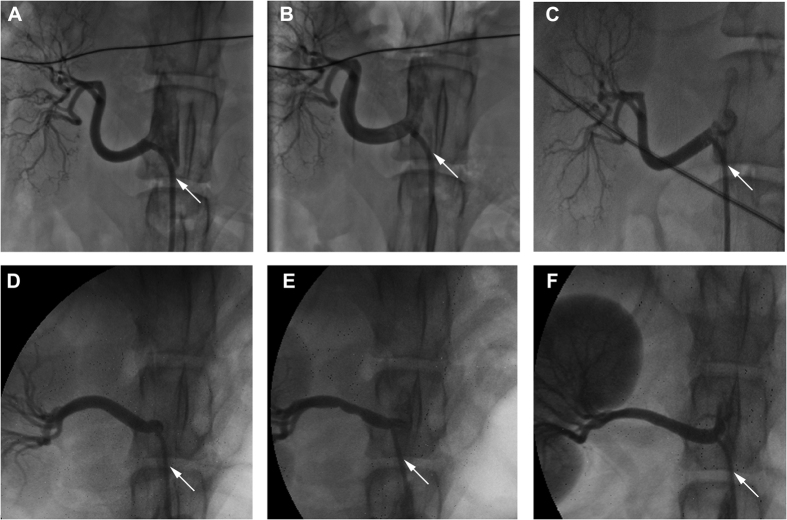
Angiograms before and after ablation.Baseline (A) 30-minute (B) and 1-month(C) renal artery angiograms were from a group B dog. The diameter of renal artery underwent renal nerve ablation via saline-irrigated catheter was markedly increased than that at baseline. Baseline (D) 30-minute (E) And 1-month (F) renal artery angiograms were from a group A dog. Similar changes were showed, but the vessel spasm caused by renal nerve ablation using temperature-controlled catheter made the observation difficult. Angiograms were calibrated using a 6 F JR4 Judkins catheter with an inner diameter of 2 mm as reference (denoted with white arrow heads).